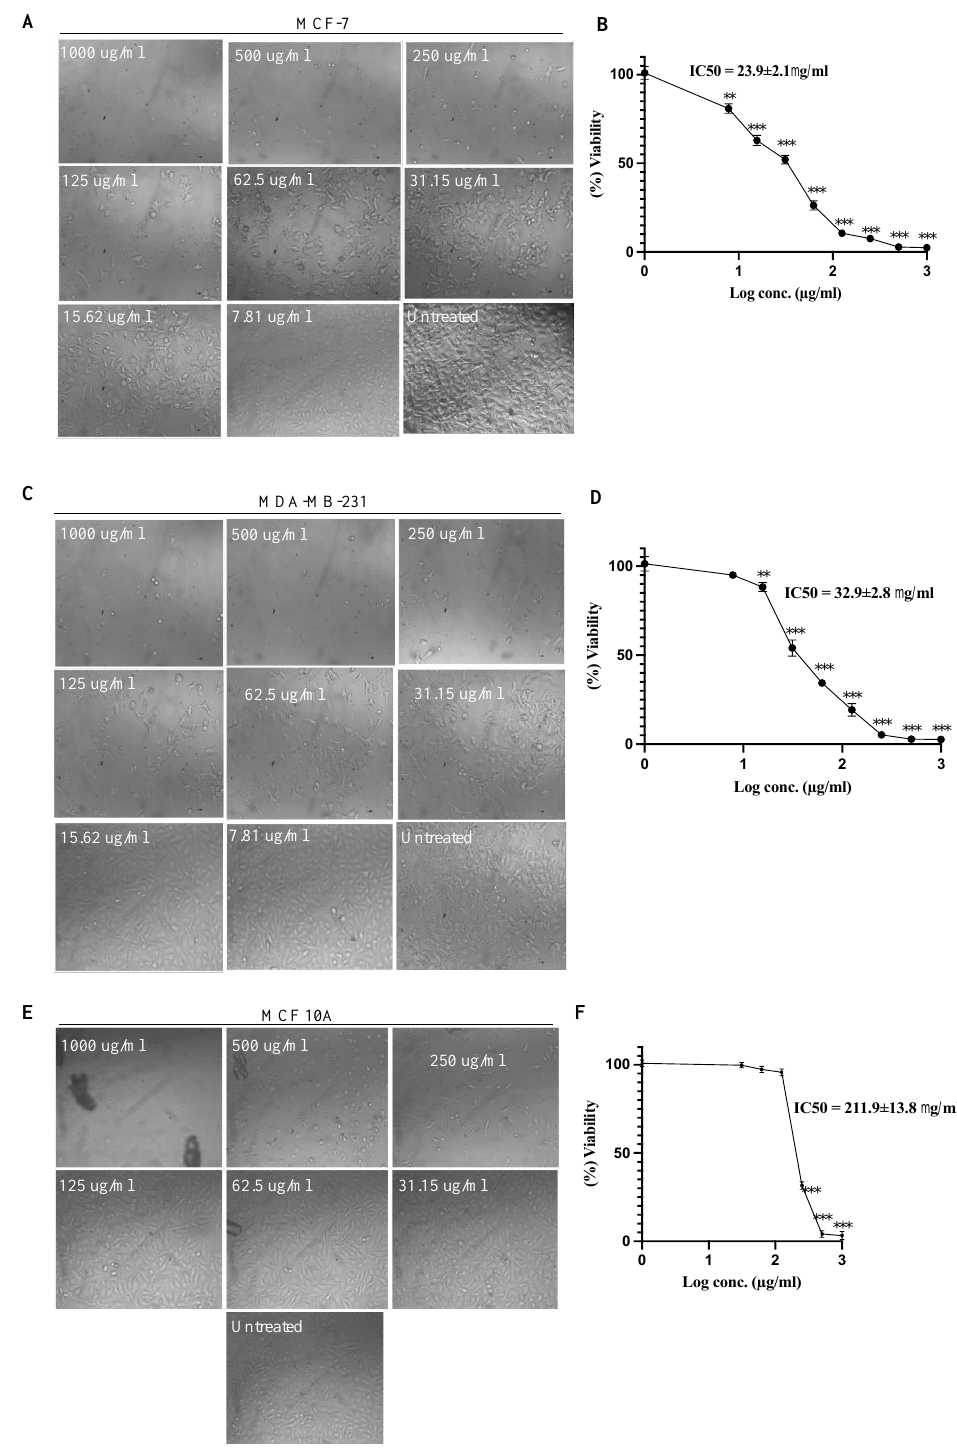
Figure 1. Effect of azilsartan on the viability of MCF-7 and MDA-MB-231 breast cancer cell lines and MCF 10A breast normal epithelial cells. ( A , C , E ) Representative images of the MCF-7, MDA-MB-231 and MCF 10A cell lines, respectively, before and after treatment with azilsartan at different concentrations for 48 h. ( B , D , F ) Percentage of viability of MCF-7, MDA-MB-231 and MCF 10A cell lines, respectively, after treatment with azilsartan for 48 h at different concentrations. Data represent mean ± SD, n = 3. Significant difference was analyzed by one-way ANOVA, where: ** p < 0.01, *** p < 0.001, compared to untreated